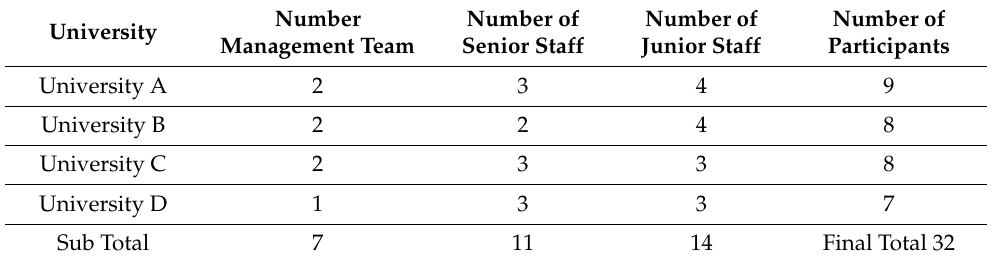
Table 1. Summary of Participants and their positions selected from Case Study